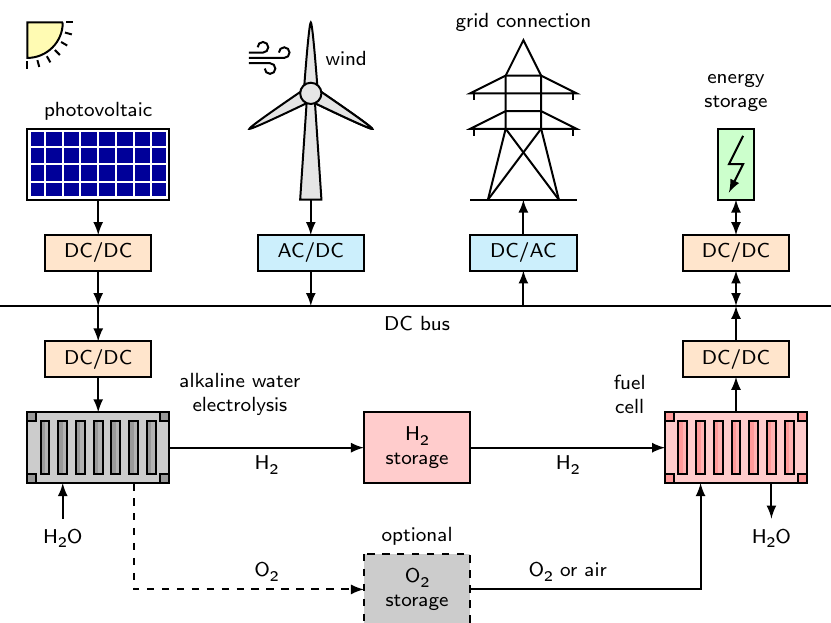
Figure 12. The schematic process scheme of a hydrogen energy system. Photovoltaic panels and wind turbines generate renewable energy to power alkaline water electrolyzers, and stored hydrogen can be converted back into electricity by fuel cells. Therefore, either oxygen or air can be utilized. Additional energy storage devices can damp fluctuations, and the complete hydrogen energy system can be used for power grid stabilization